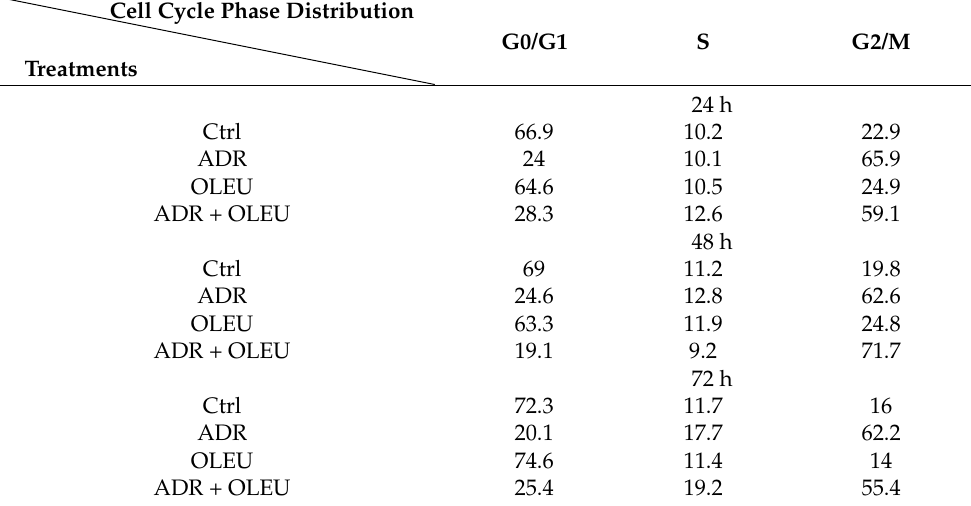
Table 1. Cell cycle phase distribution after 24, 48, 72 h (%) of exposure to ADR (Adriamycin) and OLEU (Oleuropein), alone and in co-treatment, in comparison to control cells (Ctrl). TreatmentsCell Cycle Phase Distribution G0/G1 S G2/M 24